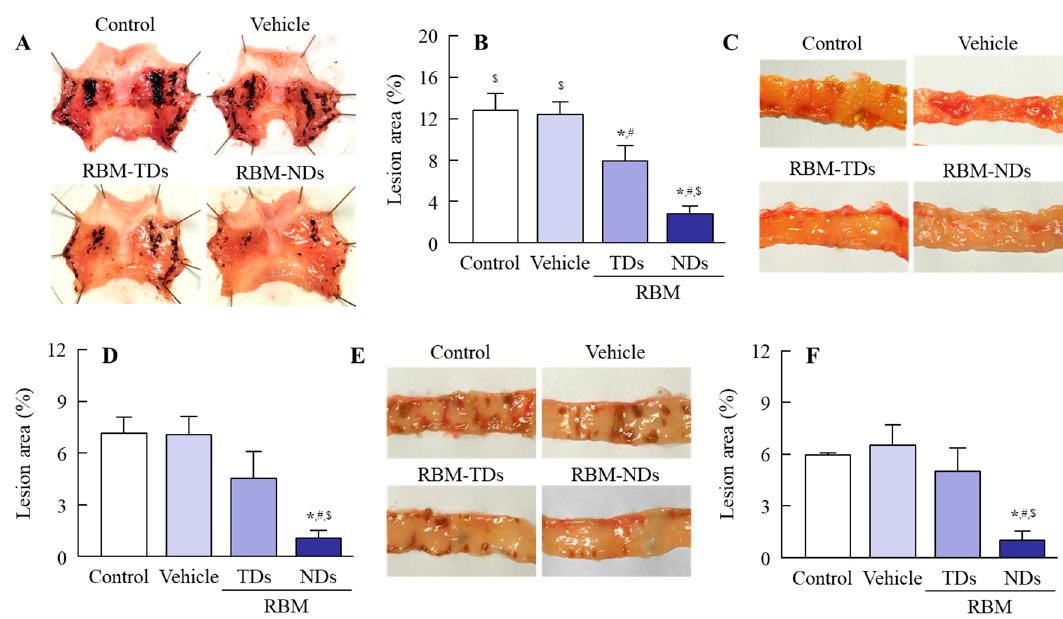
Figure 6. Therapeutic effect of RBM-NDs on IMC-induced lesions in the gastric, jejunal, and ileal mucosa of AA rats. ( A , C , E ) Representative images of stomach ( A ), jejunum ( C ), and ileum ( E ) of rats treated with vehicle, RBM-TDs, and RBM-NDs. ( B , D , F ) Changes in gastric ( A ), jejunal ( D ), and ileal ( F ) lesion areas in rats treated with vehicle, RBM-TDs, and RBM-NDs. Control: IMC-stimulated AA rat; vehicle: IMC-stimulated AA rat treated with vehicle; RBM-TDs: IMC-stimulated AA rat treated with RBM-TDs; RBM-N: IMC-stimulated AA rat treated with RBM-NDs. n = 7–11, * p > 0.05 vs. control. # p > 0.05 vs. vehicle, $ p > 0.05 vs. RBM-TDs. The oral administration of RBM-NDs decreased the GI lesion area in IMC-stimulated AA rats, and the therapeutic effect was higher than that of RBM-TDs.